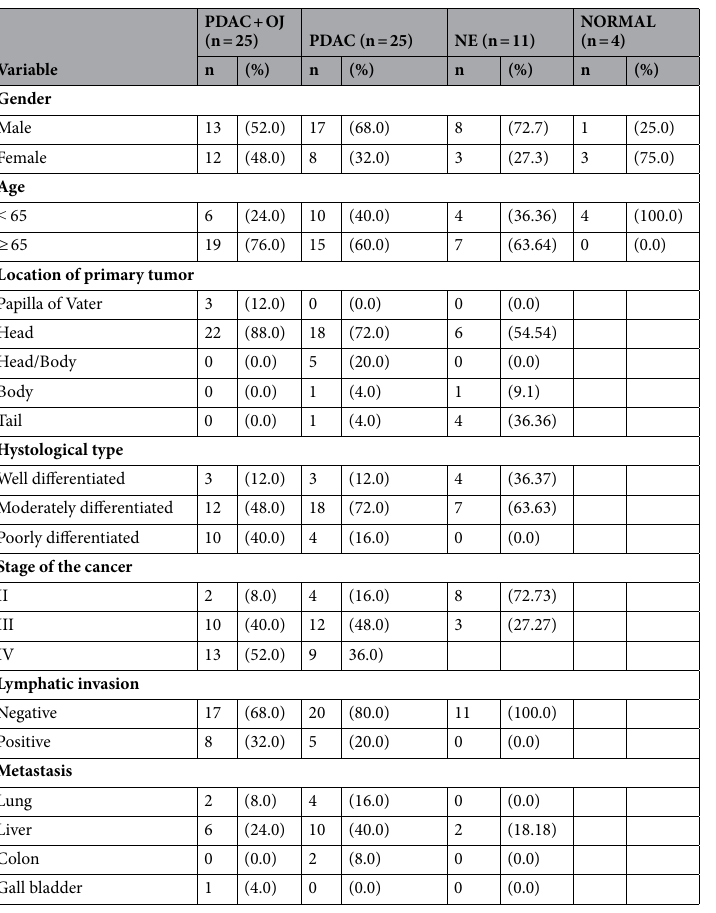
Table 2. Clinicopathological characteristics of pancreatic cancer patients selected for MUC4